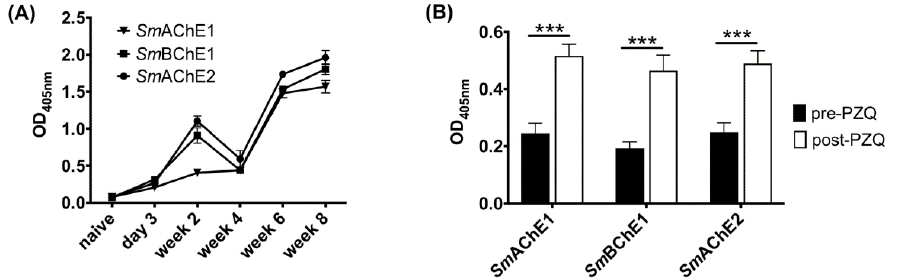
Figure 3. Antibody responses to Sm ChEs during the course of infection and following praziquantel (PZQ) treatment in mice. ELISAs showing anti- Sm ChE IgG responses in mice ( A ) from 3 days to 8 weeks post-infection ( n = 5) and ( B ) before (5 weeks post-infection) and 2 weeks after PZQ treatment ( n = 11). Data represents the mean of two technical replicates and significance was determined by the student’s t test, where *** p ≤ 0.001.